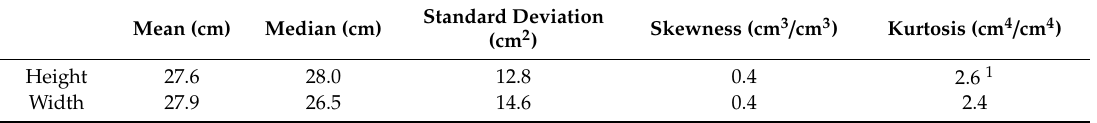
Table 1. Size statistics for the Eunicella verrucosa population monitored off Sanremo.